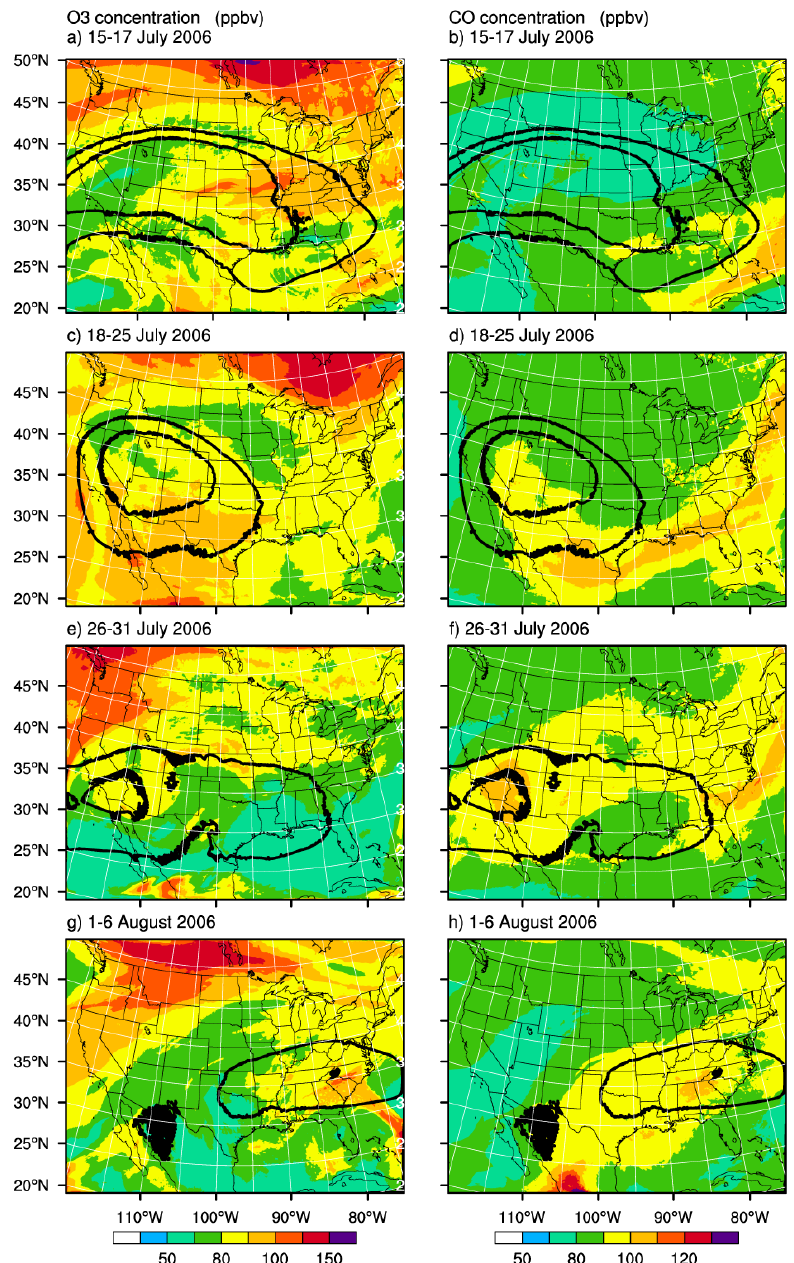
Fig. 5. Modeled O 3 (left panels) and CO (right panels) at 300hPa averaged for the 4 time periods discussed in the text. Contour levels for O 3 are 20, 50, 70, 80, 90, 100, 120, and 150ppbv and for CO are 50, 70, 80, 90, 100, 110, 120, and 150ppbv. The 9725 and 9750m heights indicate the location of the upper troposphere anticyclone. The black patch in northwest Mexico ( g and h ) is a region with geopotential height of